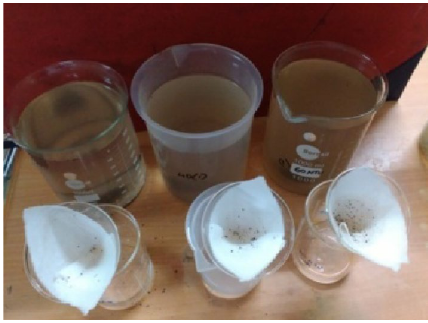
Fig. 4 Flocculation–coagulation with seeds powder